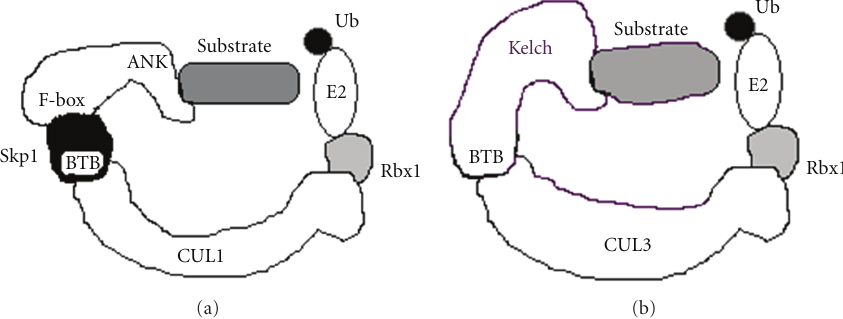
Figure 1: A schematic of two classes of orthopoxvirus E3 ubiquitin ligases: (a) SCF E3 ligase and (b) BTB-kelch/Cul3 E3 ligase.